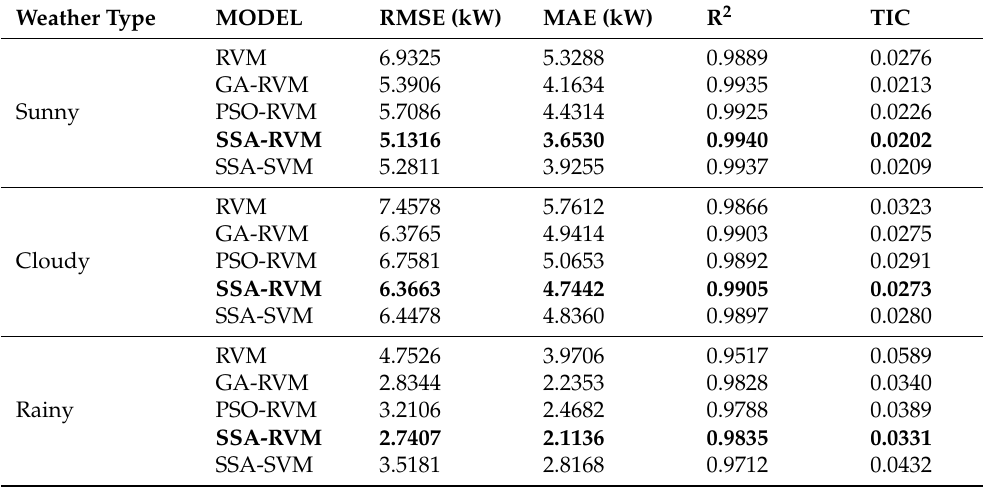
Table 3. Results of evaluation indexes of different methods under different weather types in summer.